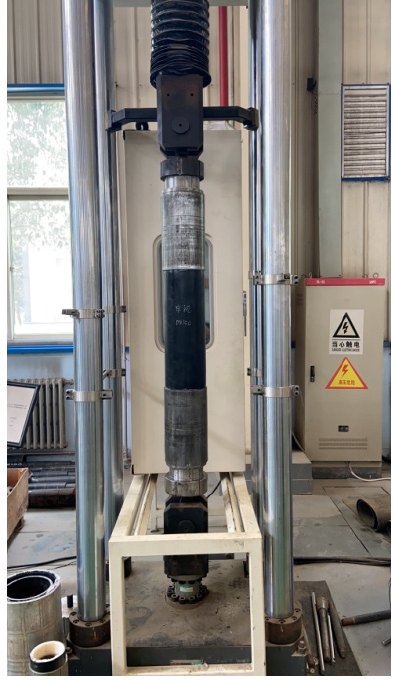
Figure 14. Tensile test of the RTP sample.